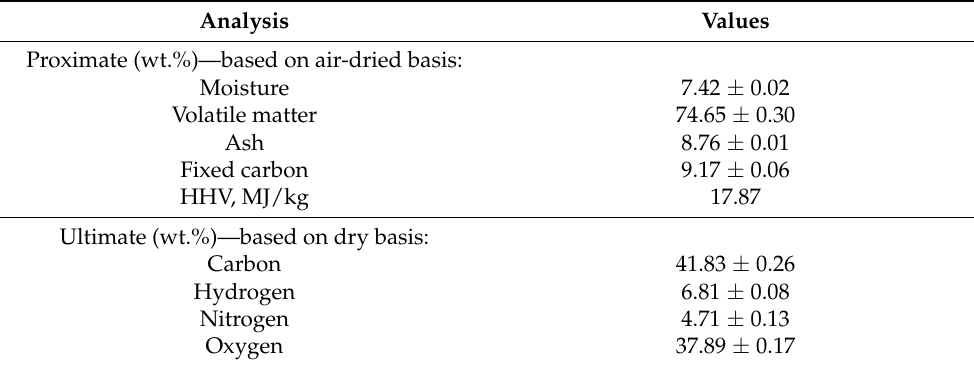
Table 1. The results of the proximate and ultimate analyses of AIW sample. Analysis